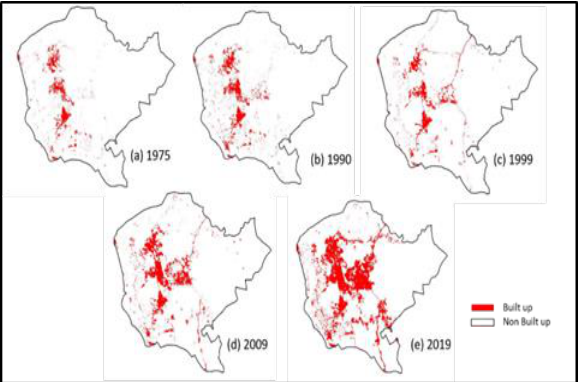
Figure 2 . Built-up